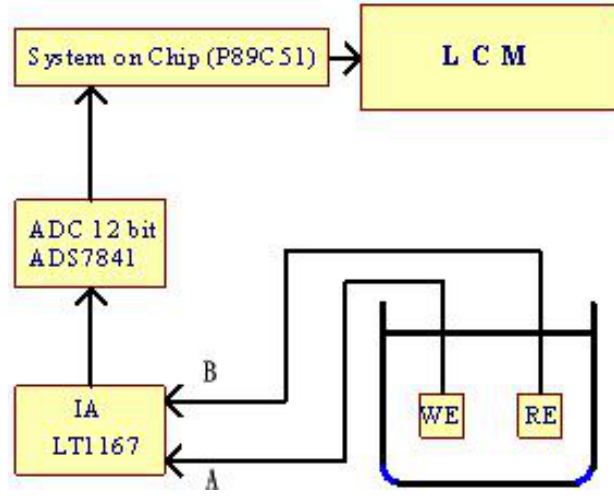
Figure 3. The system structure for potential measurement.